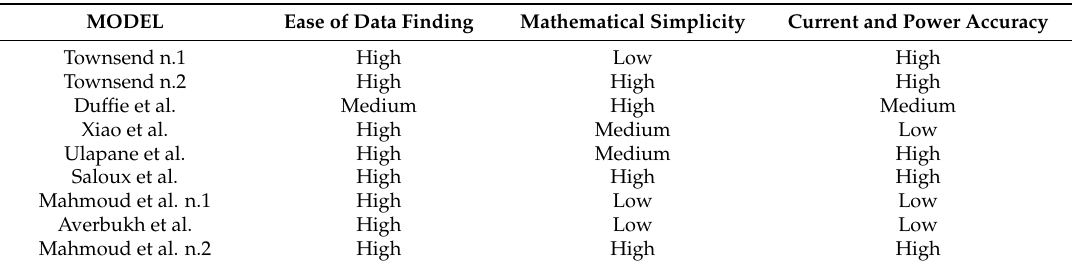
Table 16. Usability and accuracy ratings of the analysed one-diode models. MODEL Ease of Data Finding Mathematical Simplicity Current and Power Accuracy Townsend n.1 High